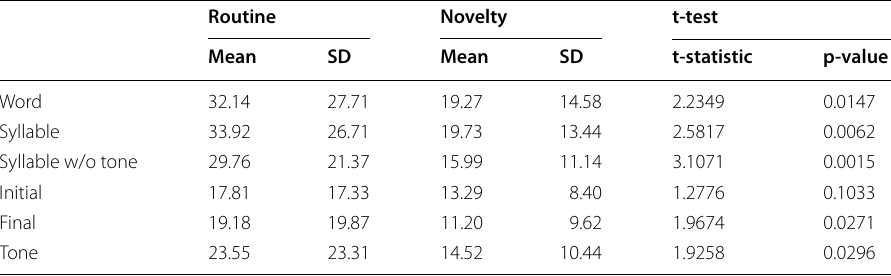
Table 1 Pretest–posttest improvements among beginning learners Routine Novelty